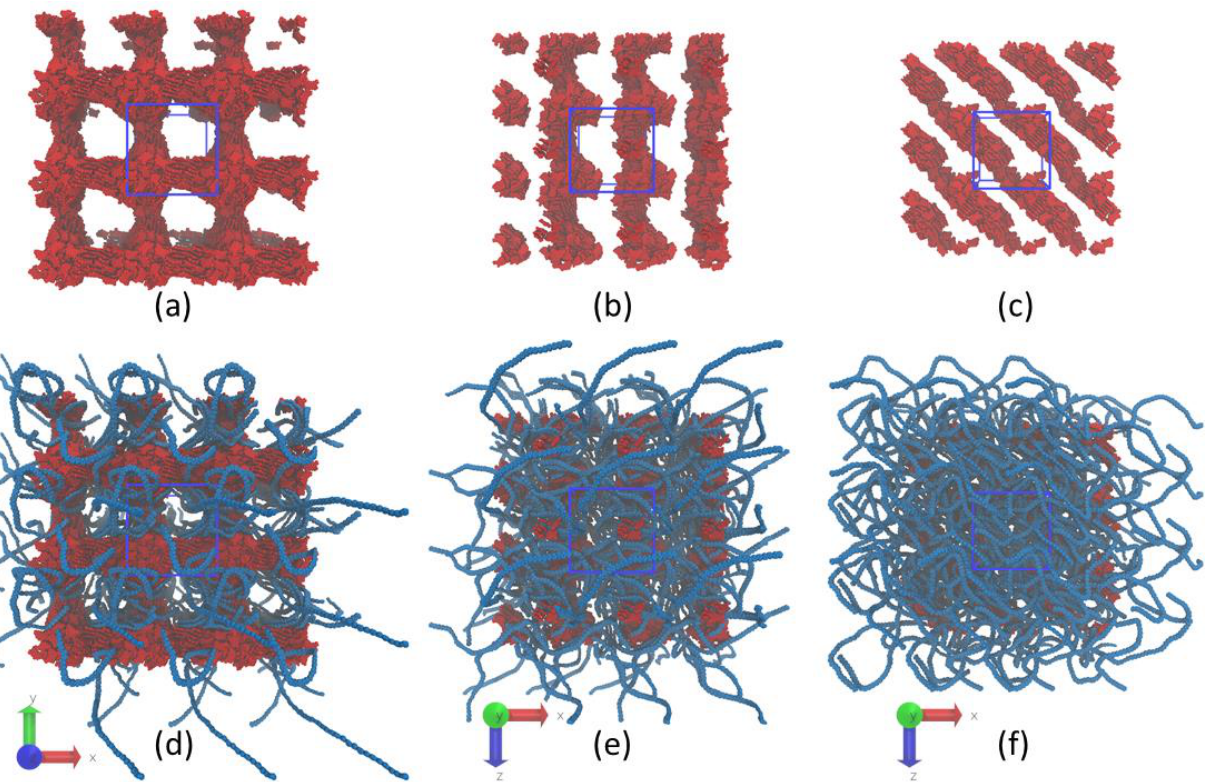
Figure 7. Typical snapshots of the ( a – c ) Asp-COOH phase and ( d – f ) Asp-COOH/P3HT blends at concentrations equal to ( a , d ) 1:1, ( b , e ) 2:3 and ( c , f ) 1:3 obtained at the end of the 5 µs long simulations. The top row shows only asphaltene molecules, while the bottom row also represents the backbones of the P3HT chains. Several periodic images are represented in each snapshot. The blue cube denotes the periodic simulation box. Aliphatic side groups are not represented for